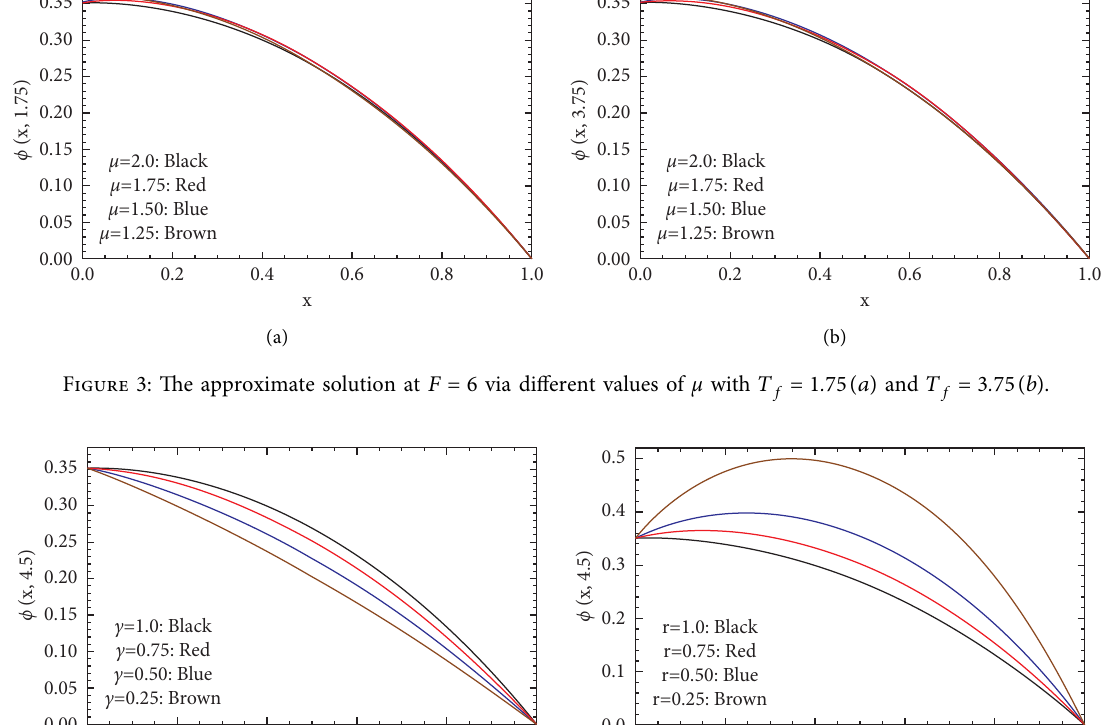
γ =1.0: Black γ =0.75: Red